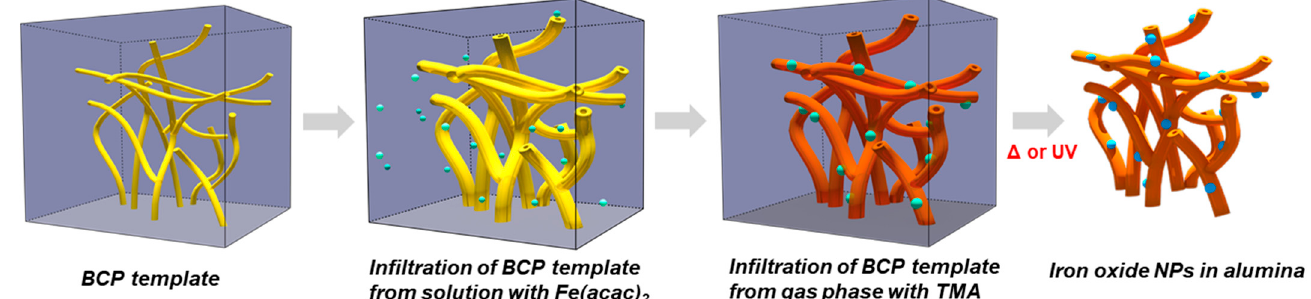
Figure 1. Schematic of synthesis of iron oxide nanoparticles (NPs) in a porous alumina matrix using a two-step infiltration process. The polar domains of polymer block copolymers (BCP) (here PS-P4VP) are infiltrated first with the iron precursor (Fe(acac) 2 ) from ethanol solution followed by the infiltration with vapors of alumina precursors (TMA and H 2 O). Note that the immersion of BCP into ethanol solution is accompanied by its swelling. The BCP template is removed by either thermal annealing or plasma treatment resulting in the formation of all-inorganic heterostructure consisting of iron oxide NPs in porous alumina.